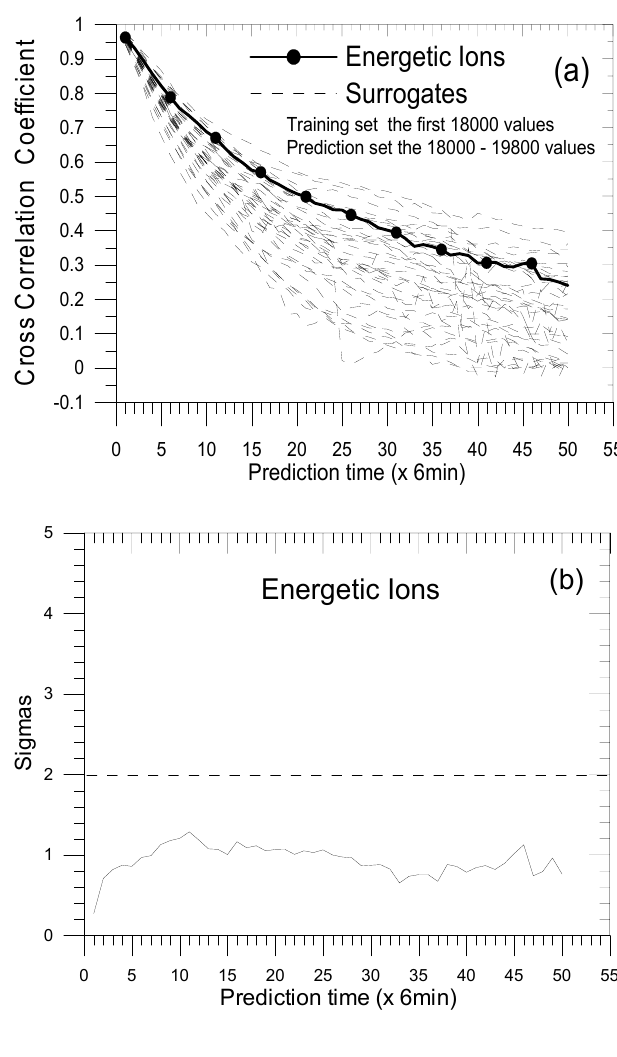
Fig. 7. (a) Correlation coefficient be- tween predicted and real values for en- ergetic ions’ time series and its surro- gate data as a function of prediction time, estimated for embedding dimen- sion m = 6, delay time τ = 30 and k = 16 neighbors. (b) Significance of the discriminating statistic for the cor- relation coefficient shown in